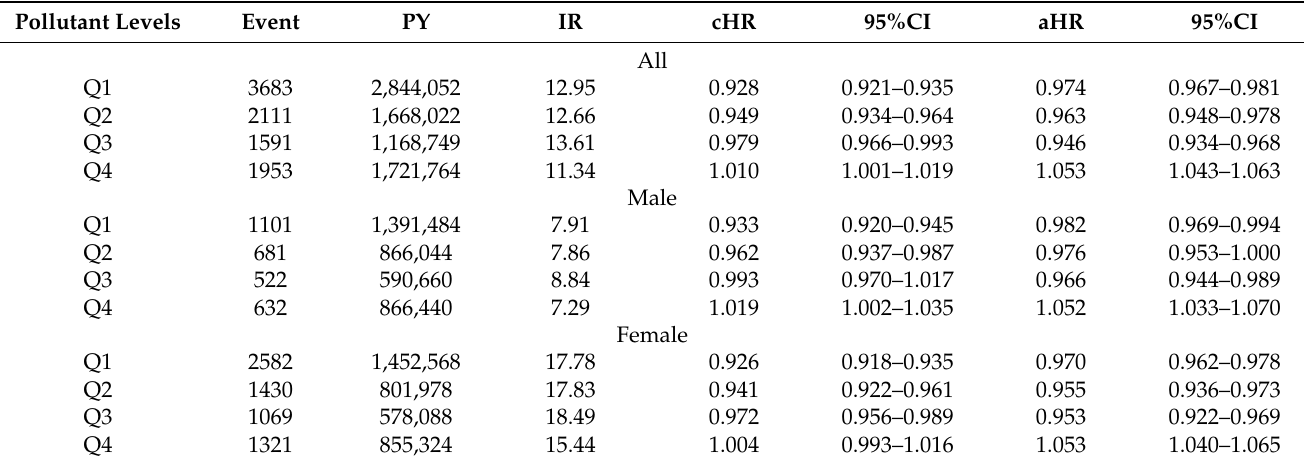
Table 2. Comparison of RA incidence and related HR differences among participants exposed to average annual concentrations of